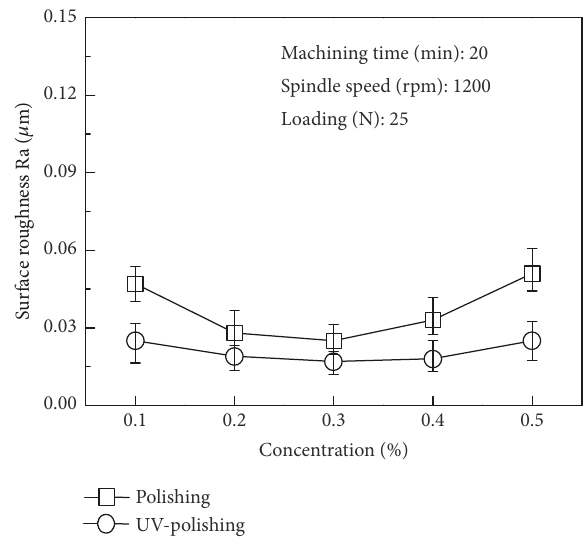
Figure 5: Impacts of spindle speed on surface roughness.